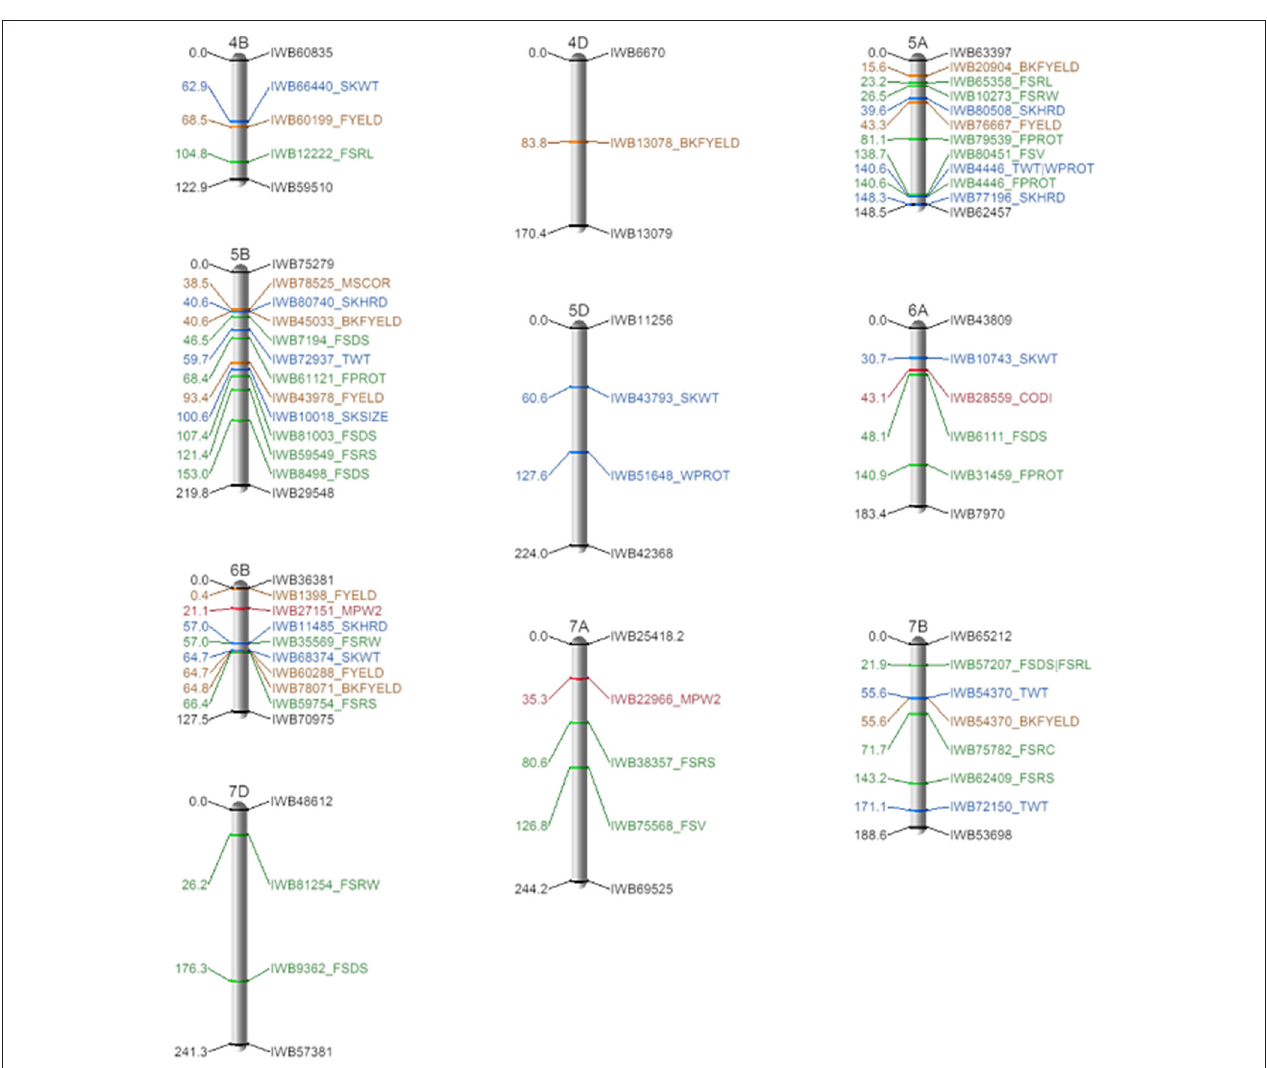
FIGURE 4 | Location of the 105 MTAs for end-use quality traits detected in the Pacific Northwest soft white winter wheat diversity panel. Genetic linkage maps of the chromosomes are based on the wheat consensus SNP map ( Wang et al., 2014). Values on the left are genetic distance in centimorgan (cM). On the right, SNP ID and the associated end-used quality traits. See Table 1 for complete description of trait abbreviations. Trait groupings are color coded. Blue, grain characteristics; Green, flour parameters; Brown, milling traits; Red, baking parameters. SKHRD, kernel hardness; SKSIZE, kernel size; SKWTkernel weight; TWT, test weight; WPROT, grain protein; BKFYELD, break flour yield; FYELO, total flour yield; MSCOR, milling score; FASH, flour ash; FPROT, flour protein; FSOS, flour SDS sedimentation; FSRC, carbonate solvent retention capacity; FSRL, lactic acid solvent retention capacity; FSRS, sucrose solvent retention capacity; FSRW, water solvent retention capacity; FSV, flour swelling volume; MPW2, mixograph width 2 mins; CODI, cookie